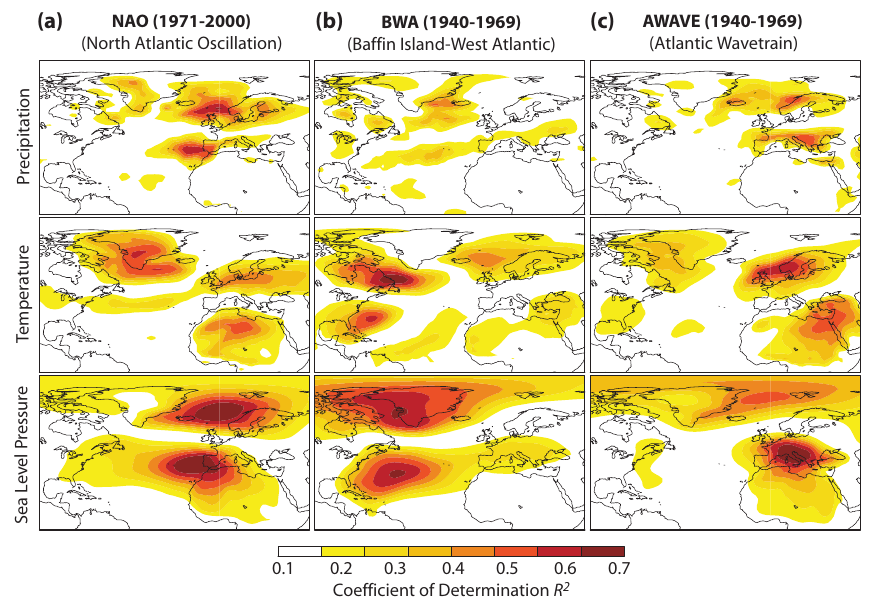
Fig. 7. Coefficient of determination of (a) the North Atlantic Oscillation (NAO), (b) the Baffin Island–West Atlantic pattern (BWA), and (c) the Atlantic Wave Train (AWAVE) for precipitation, surface air temperature, and sea level pressure, deduced from the TCR ensemble mean. The time period 1971–2000 is defined as the reference period; 1940–1969 is the 30-year period of largest disagreement in teleconnec- tivity from the reference period. See text for further details.